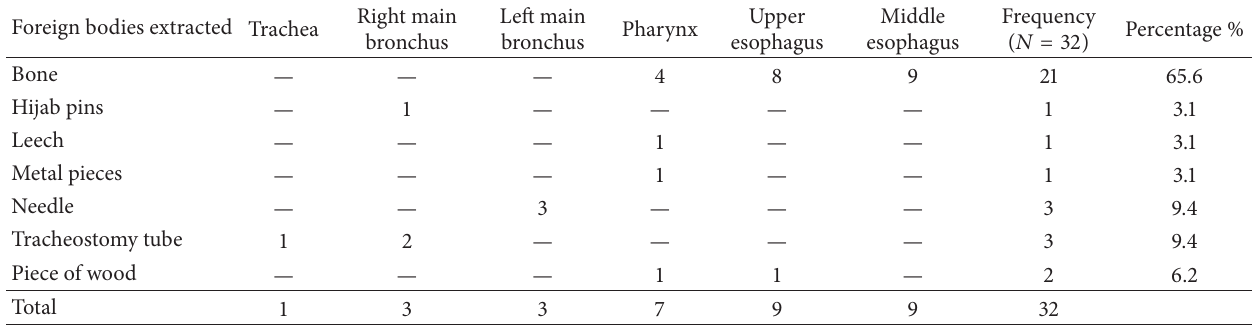
Tracheostomy tube